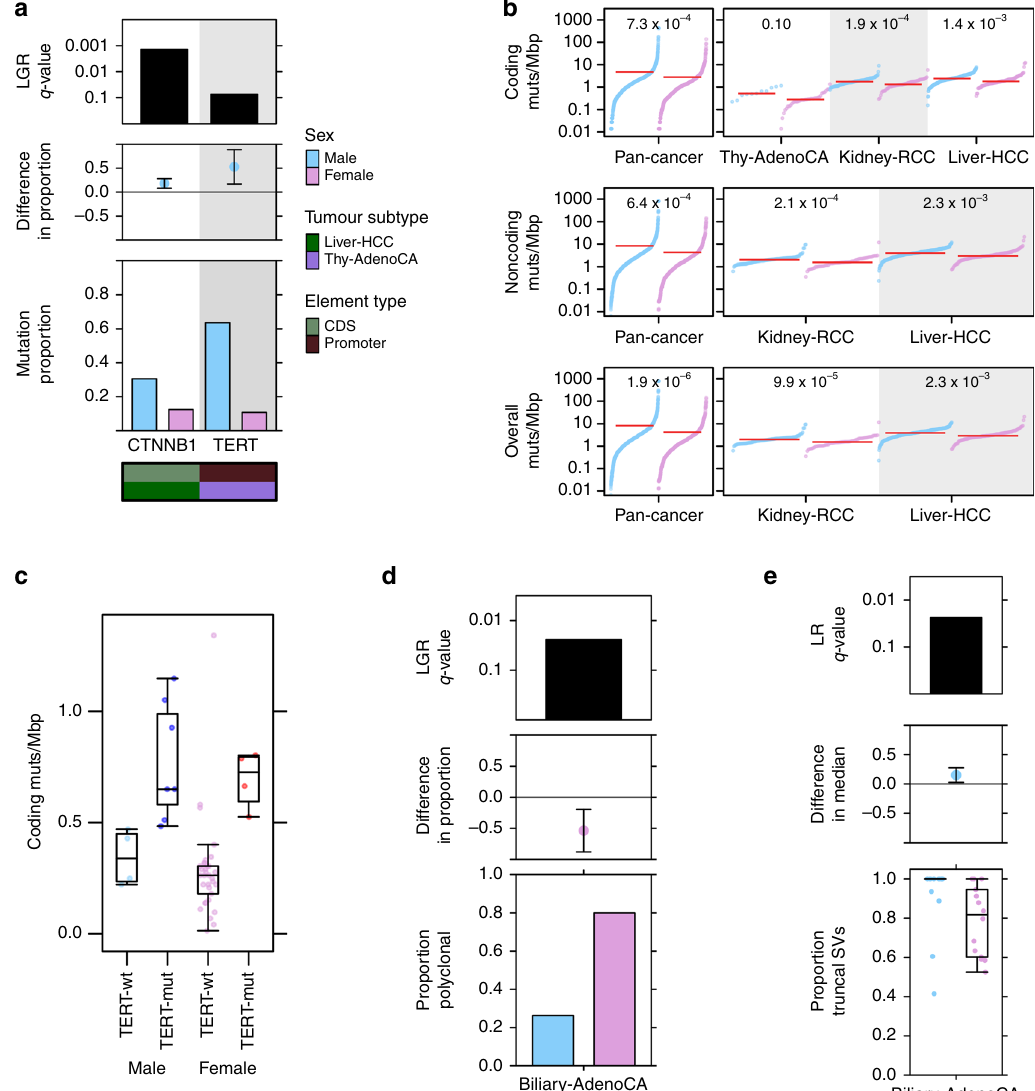
Fig. 1 Sex-biases in mutation frequency of driver genes, SNV density and tumour evolution. a From top to bottom, each plot shows the logistic regression q -value for the sex effect; difference in proportion of mutated samples between the sexes with blue denoting male-dominated bias; and mutation proportion for each gene. Covariate bars indicate mutation context and tumour subtype of interest. b The burden of somatic SNVs for coding, non-coding and overall mutation load. Linear regression q -values are shown. c Coding mutation load for thyroid adenocarcinoma samples compared by sex and presence or absence of TERT promoter mutations. d The proportion of polyclonal samples and e the proportion of truncal structural variants in biliary cancer. Tukey boxplots are shown with the box indicating quartiles and the whiskers drawn at the lowest and highest points within 1.5 interquartile range of the lower and upper quartiles, respectively. Error bars show the 95% con fi dence interval for the difference in proportions or medians between the